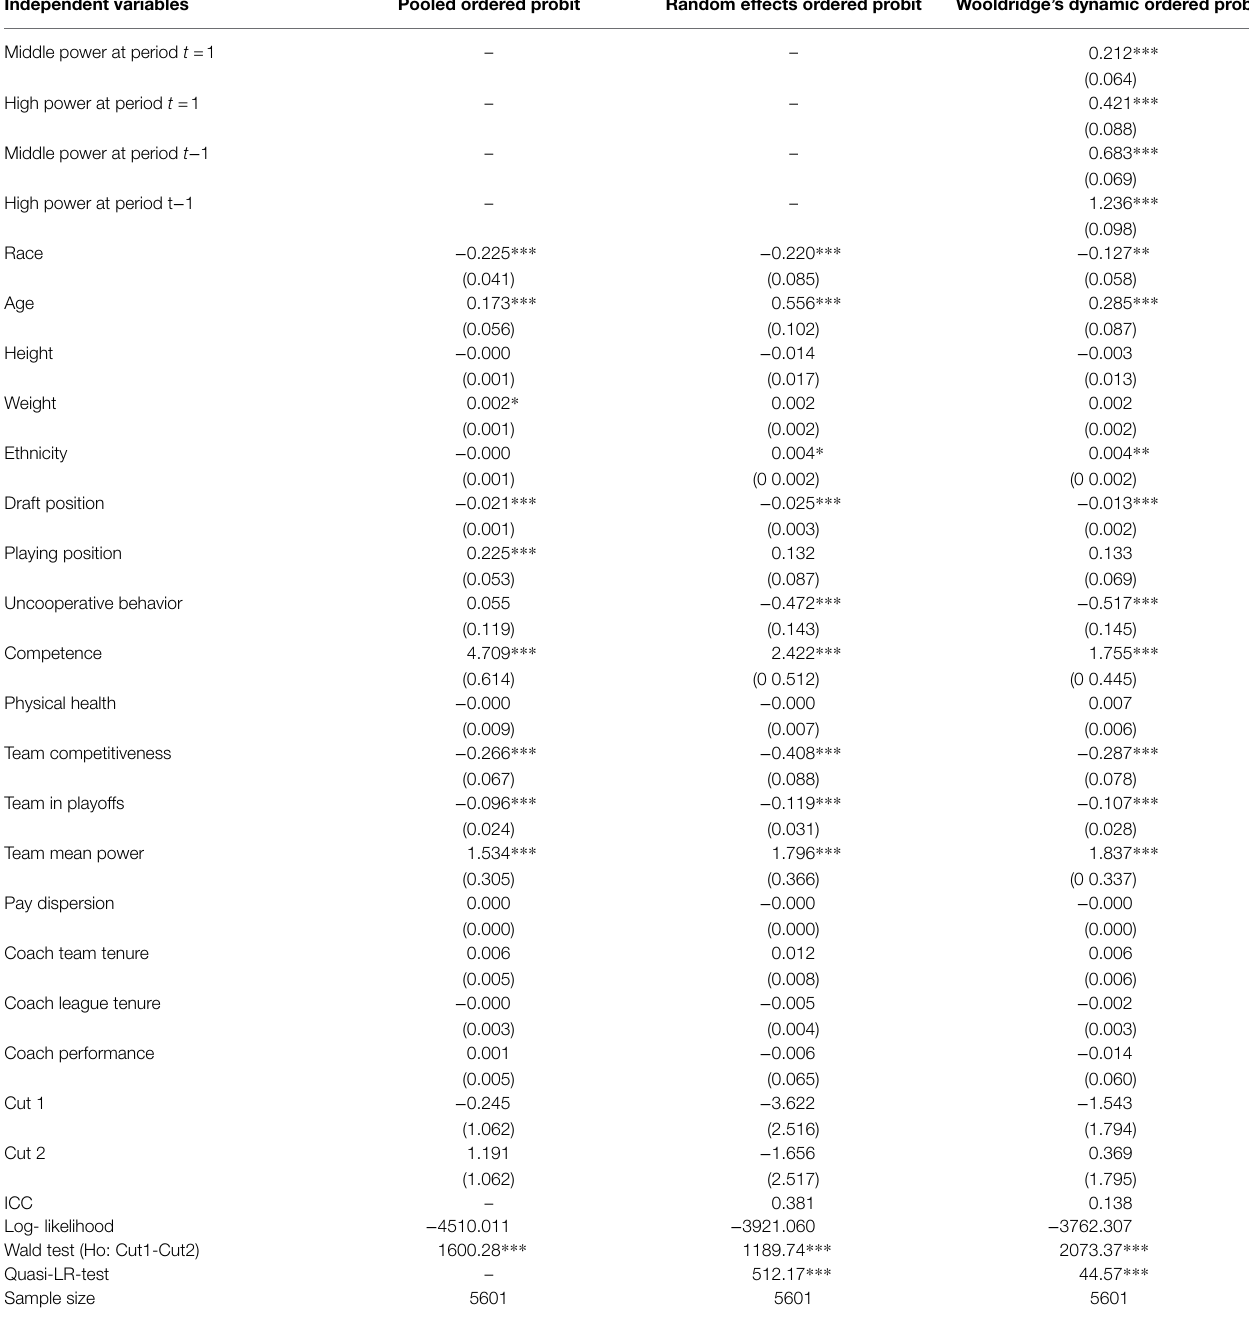
TABLE 3 | Coefficients of the pooled ordered probit, random effects ordered probit, and Wooldridge’s dynamic ordered probit models on the probability of power. Independent